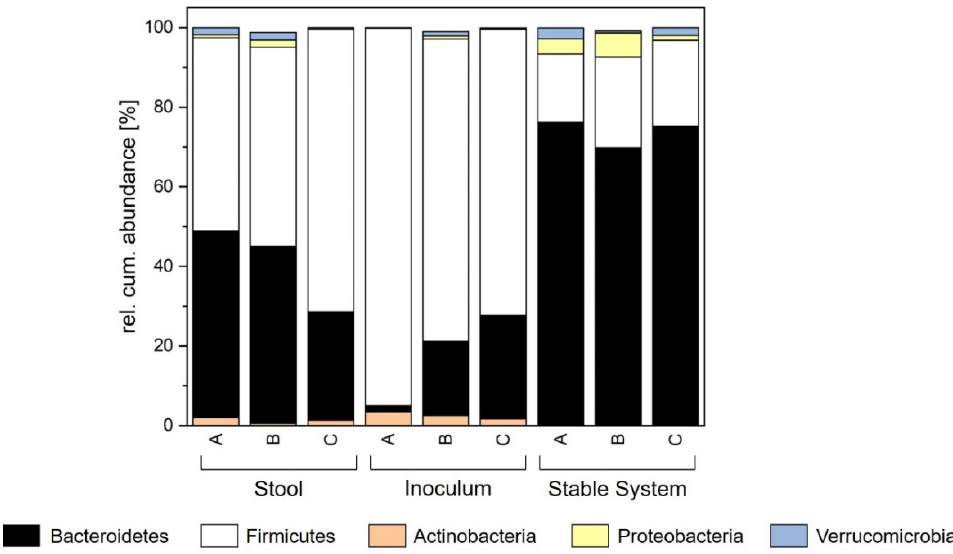
Figure 4. Comparison of relative cumulative abundance of the major phyla for stool, inoculum and stable system for each donor.